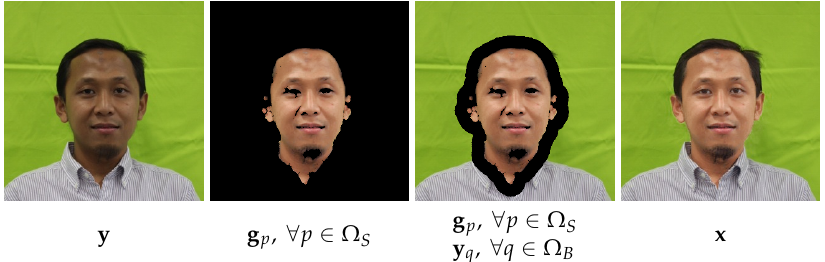
Figure 5. Guide image filtering. From left: Input image, Guide image, Target color in Ω B and Ω S , and Color transformed